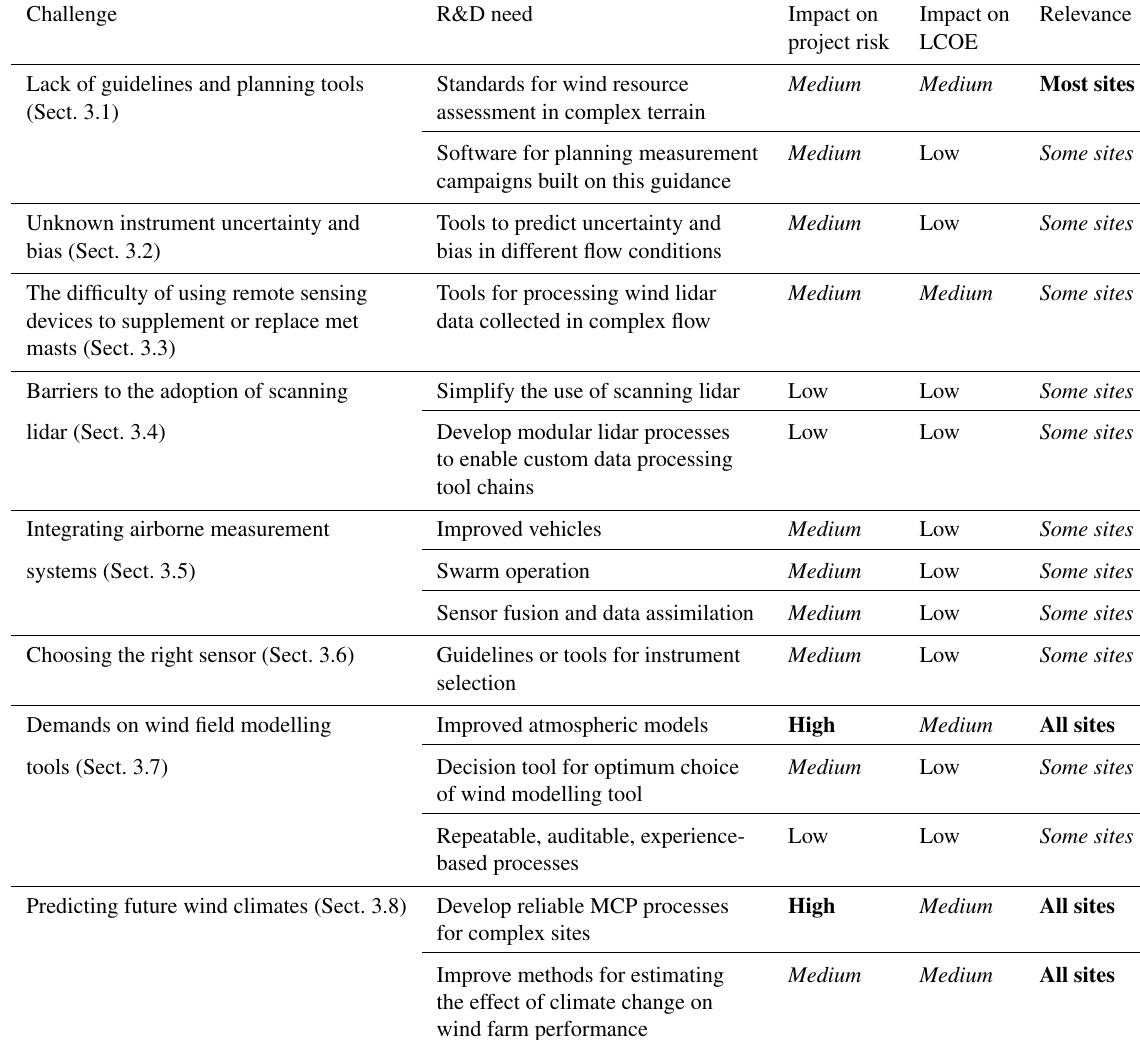
Table 2. Challenges and R&D needs for wind resource assessment in complex locations. The table follows the format of Table